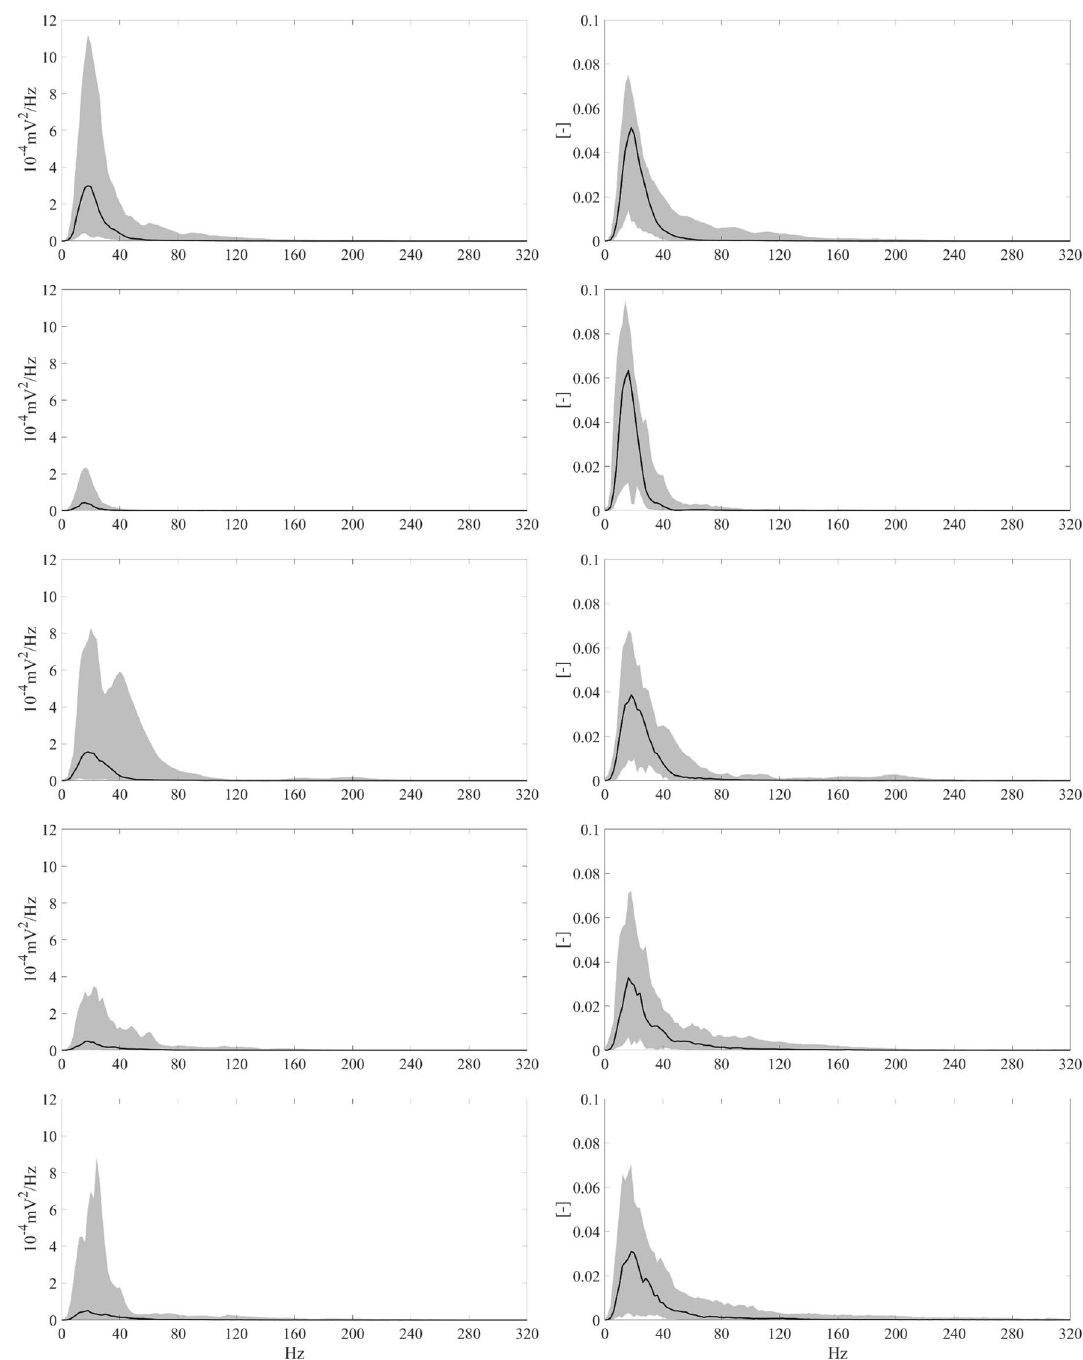
Figure 5. Absolute and normalised PSDs for all EGM types. Representative PSDs for both physiological and pathological signals in terms of medians (black solid line) and 5th and 95th percentiles (grey zones). From top to bottom: PSDs for border, scar, LP1, LP2 and EP EGMs. The left column illustrates standard PSD curves, whilst the right column depicts the same PSD curves after normalisation so that the area under each curve is unitary, thus allowing for a comparative overview of both absolute and relative power contents for all EGM types in different